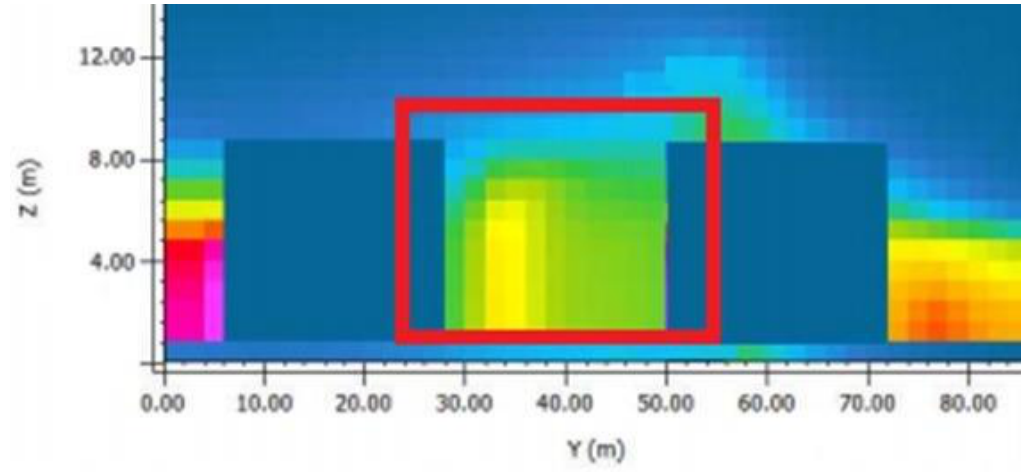
Figure 8. Geometry and boundary conditions (red square) of the urban layout using ENVI-Met.